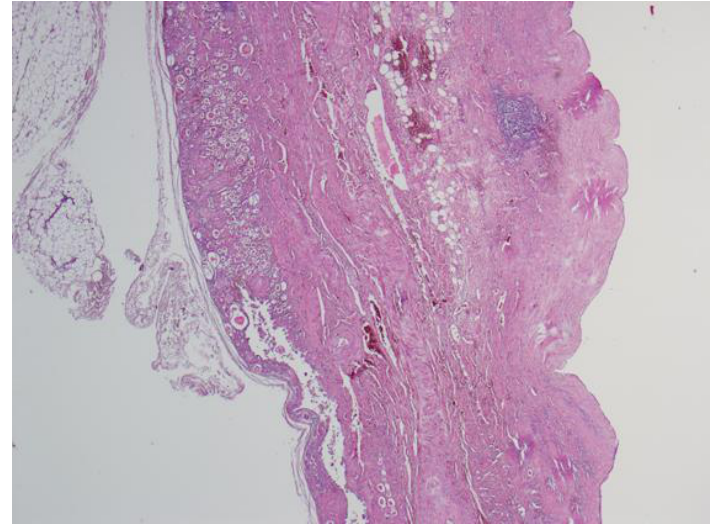
FIGURE 1. Tubular thyroidization and atrophy, interstitial fibrosis, and patchy lymphoplasmacytic inflammatory infiltrate in the kidney